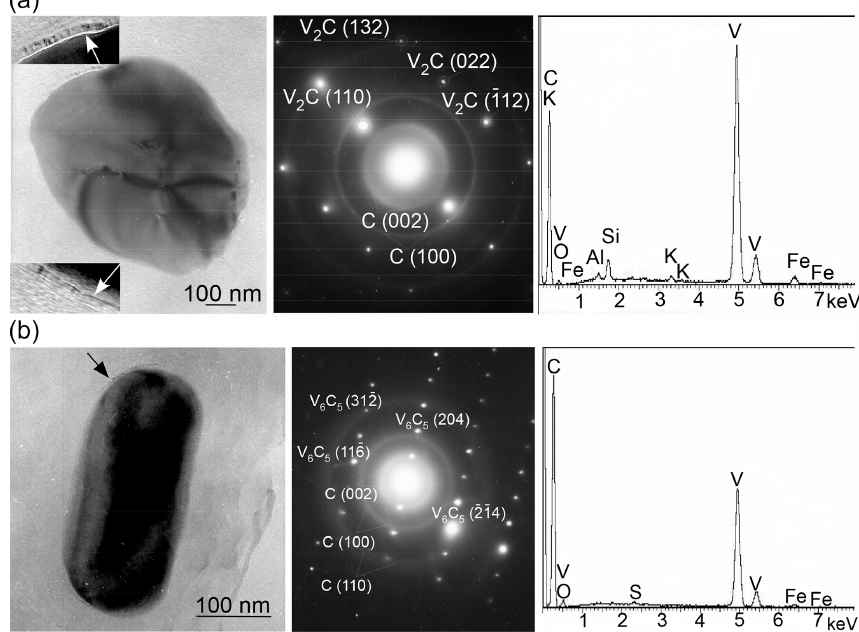
Figure 3. TEM images and corresponding SAED patterns, as well as the EDS spectra of single crystals of compositionally variable vanadium carbides in Sh1 samples: (a) V 2 C (ICDD – 01-071-1258) and (b) V 6 C 5 (ICDD – 01-080-2287). Vanadium carbides display point diffraction maxima, while shungite (turbostratic layering) exhibits ring diffraction maxima. The ordered carbon film on the surface of micro-sized minerals is indicated by arrows.